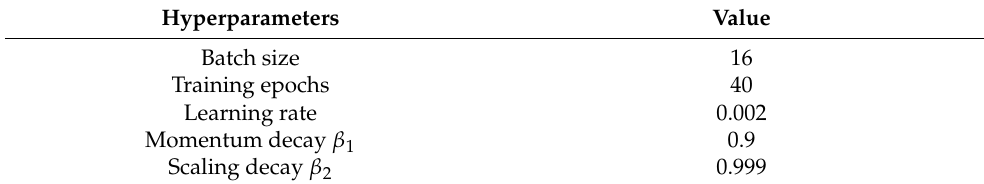
Table 3. The hyperparameters for BNN